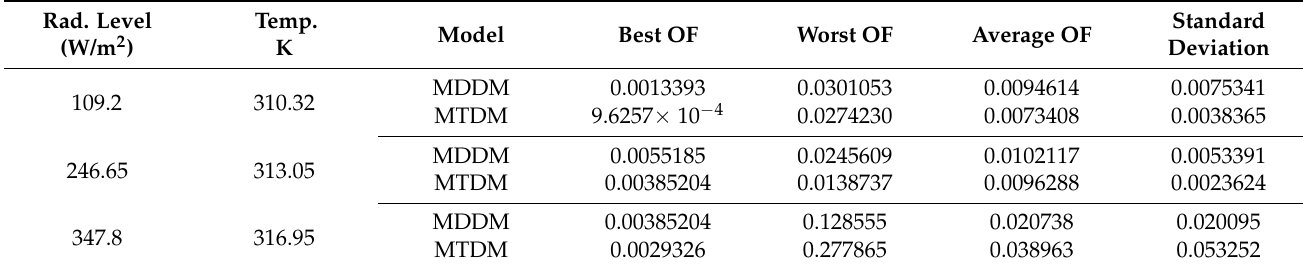
Table 5. Statistical analysis for MDDM and MTDM by EHO algorithms for CS6P-240P solar module at different irradiance and temperature